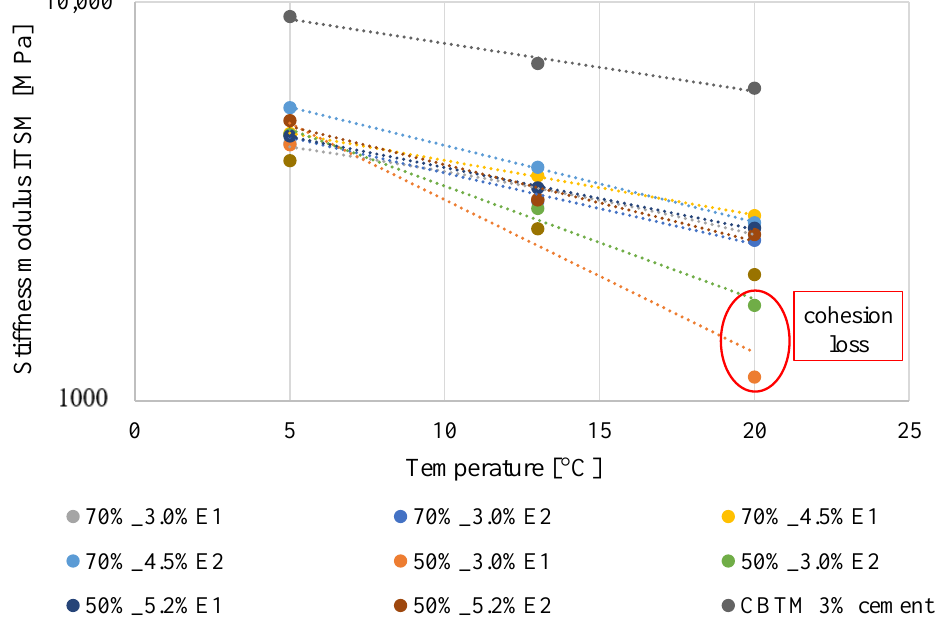
Figure 3. ITSM values as a function of the testing temperature.